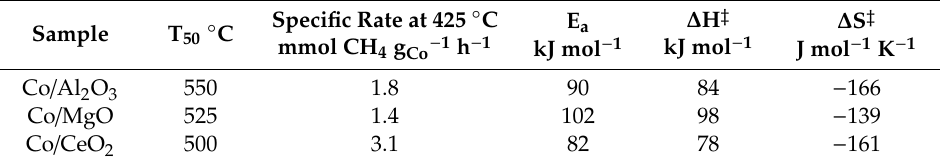
Figure 8. Relationship between the activity and the redox properties of the supported catalysts.